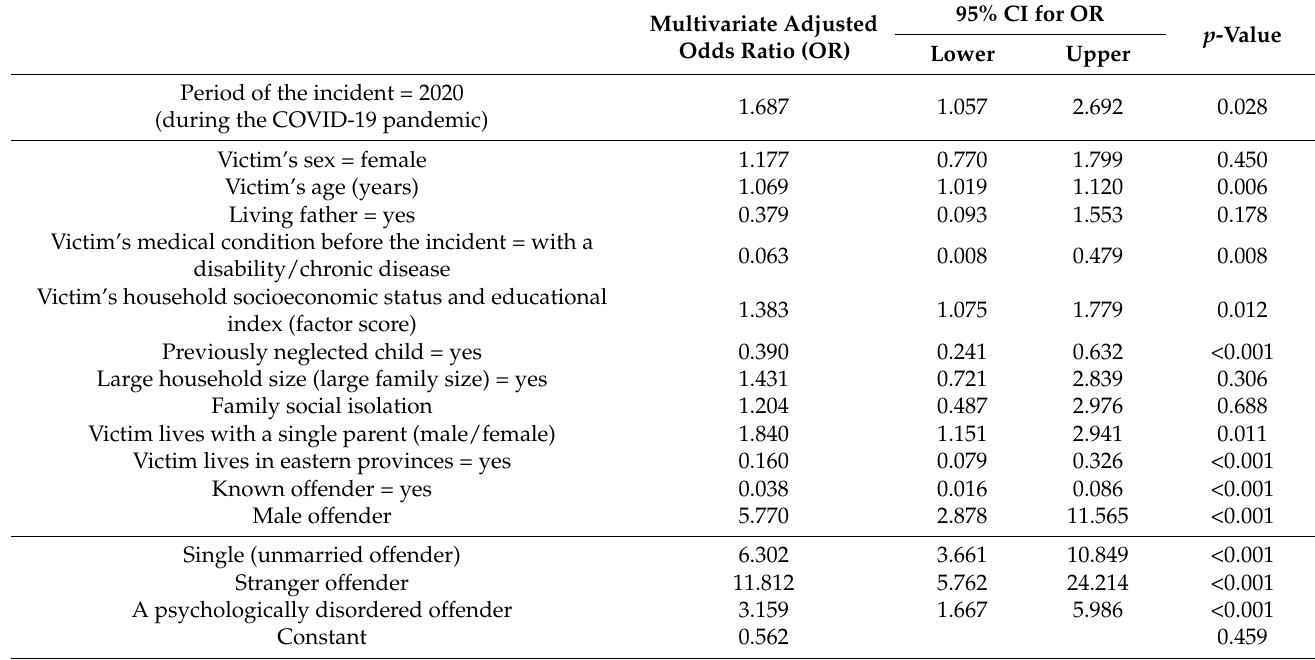
Table 5. Multivariate logistic binary regression analysis of children’s odds of sexual abuse ( n = 1304).